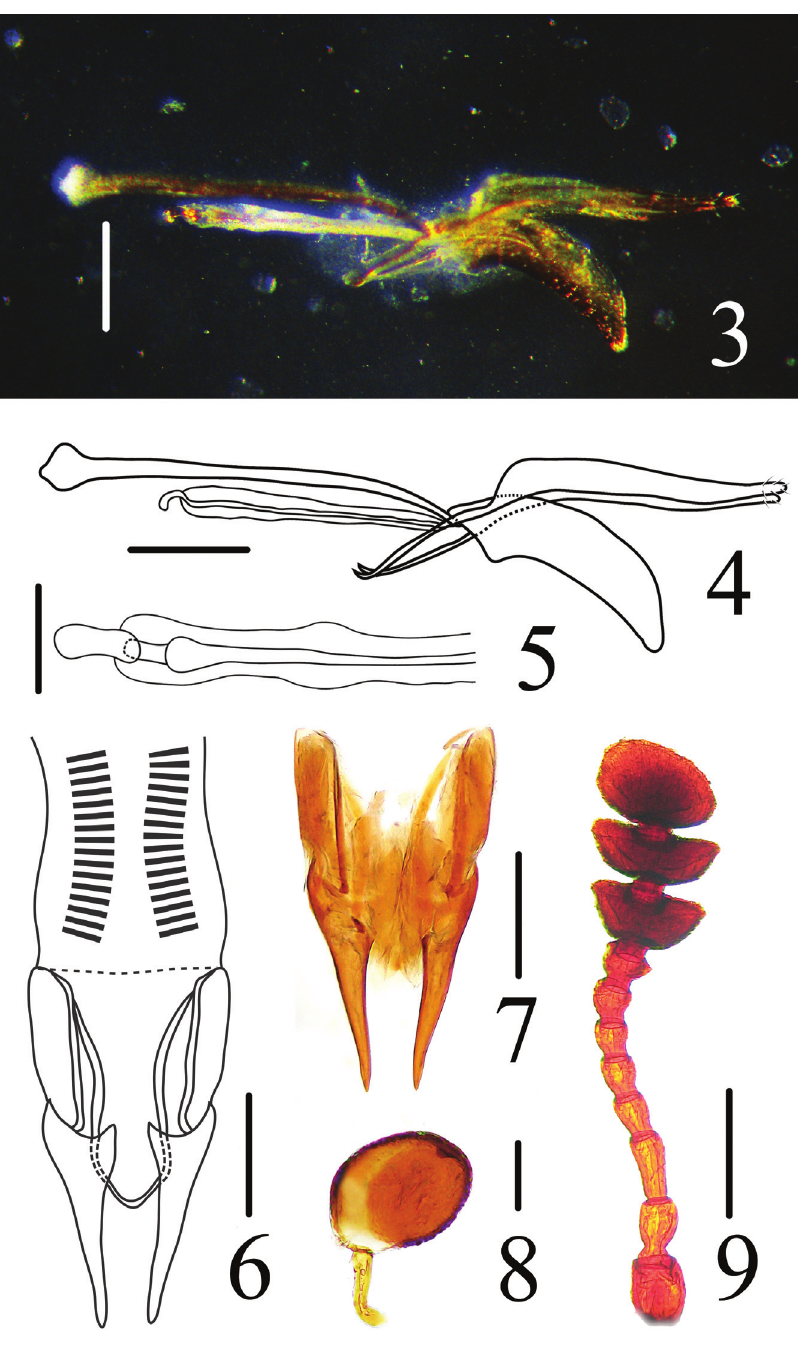
Figures 3–9. Dacne ( Xenodacne) tangliangi . 3, 4 aedeagus in lateral views 5 internal sac and flagellum in dorsal view 6, 7 female genitalia in ventral views 8 female spermatheca 9 antenna. Scales = 0.05 mm( 5, 8 ), Scales = 0.2 mm( 3, 4, 6, 7, 9